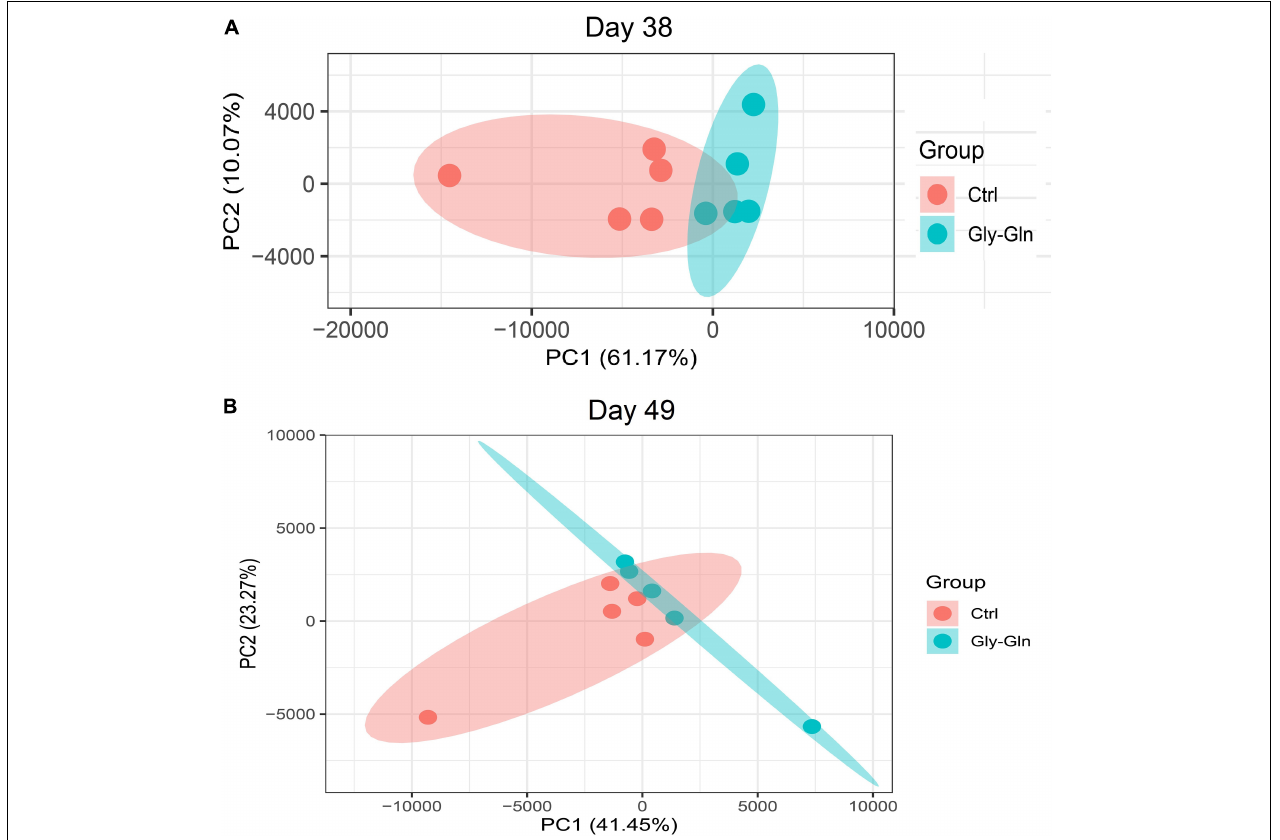
FIGURE 3 | PCoA of gut microbiota between the Ctrl and Gly-Gln group ( n = 5). (A) PCoA of gut microbiota on day 38; (B) PCoA of gut microbiota on day 49. The PC1 and PC2 in the axis indicated the top 2 percentage of gut microbiota variation explained by dietary Gly-Gln supplementation treatment.